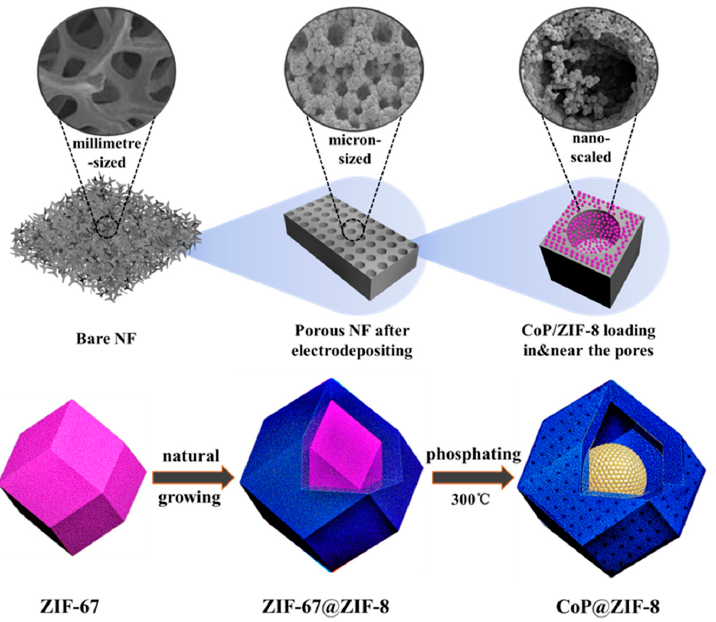
Figure 1. The spatial three-level structure of the CoP@ZIF-8/pNF and schematic illustration of the synthesis of the CoP@ZIF-8.